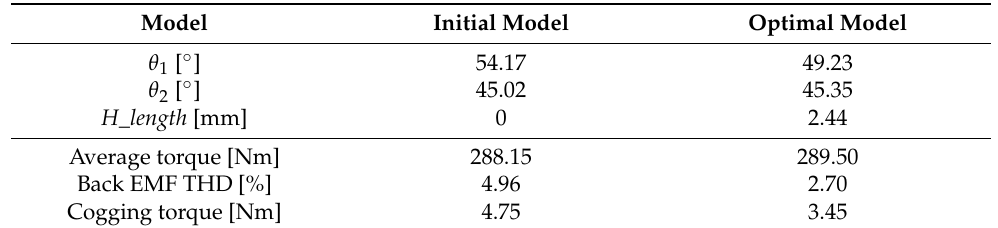
Table 3. The result of optimization.